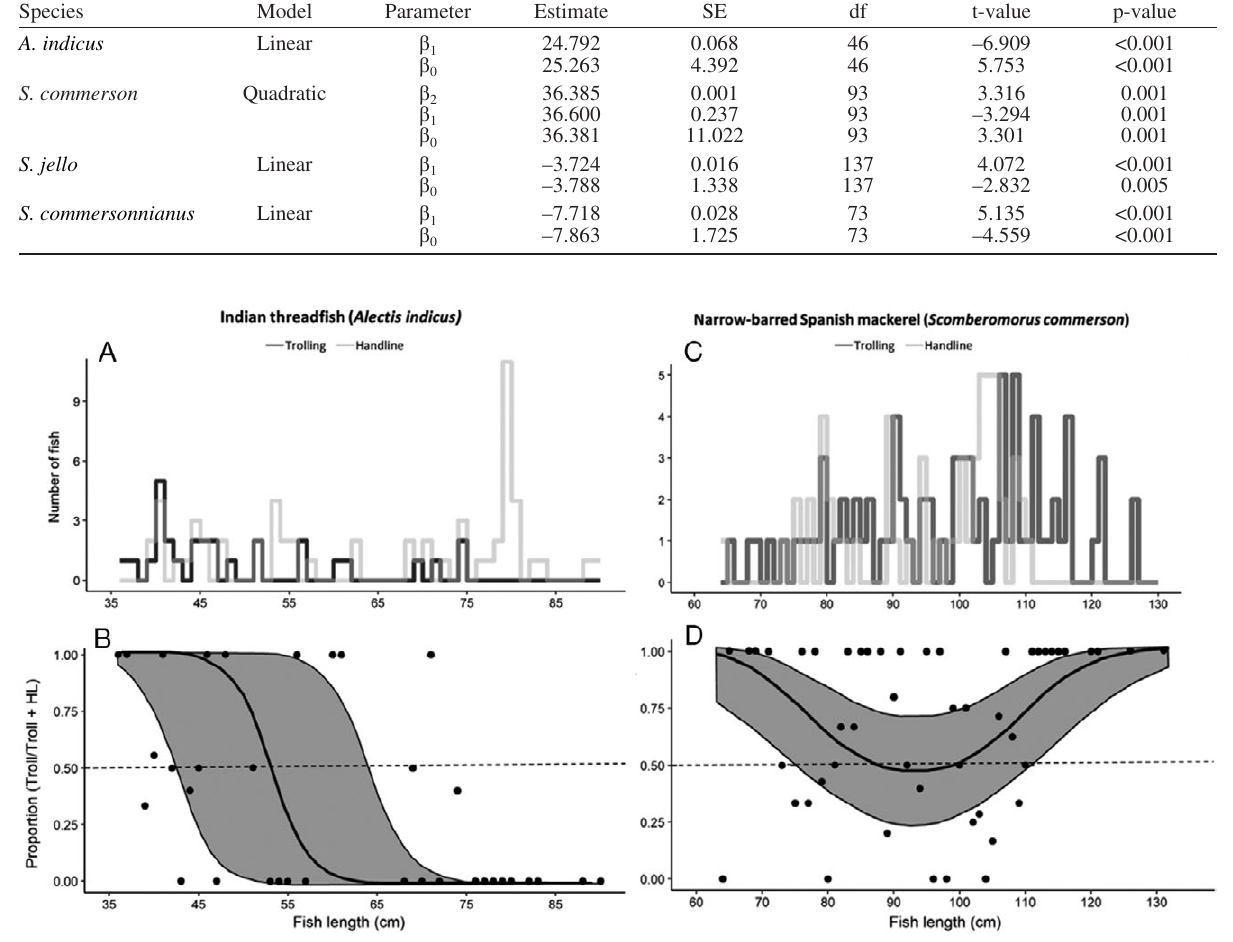
Fig. 2. – Length frequency of Indian threadfish (A) and narrow-barred Spanish mackerel (C) from trolling (solid line) and handline (dashed line) gear. Catch proportions [trolling/(trolling + handline)] between gears (circles) and GLMM-modelled proportions of catch-at-length by trolling and handline gear for Indian threadfish (B) and narrow-barred Spanish mackerel (D). Predicted mean is the black line and grey areas are the 95% confidence intervals. A value of 0.5 indicates an even split between gears for the specific length; a value of 0.75 indicates that 75% of fish caught at this length were captured by trolling and 25% by handline